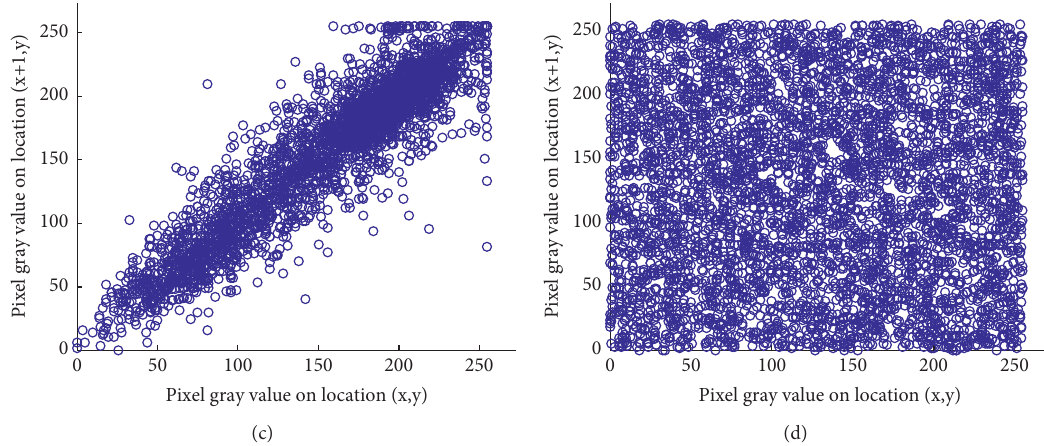
Figure 5: Correlation of adjacent pixels in «article_oeuf_taeniaC2.jpg image. (a) and (c) The distribution of horizontal and vertical adjacent pixels in the plain image. (b) and (d) The distribution of horizontal and vertical adjacent pixels in the corresponding encrypted